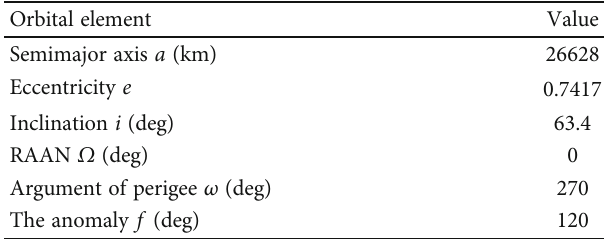
Table 1: Initial orbital elements of the target [1,